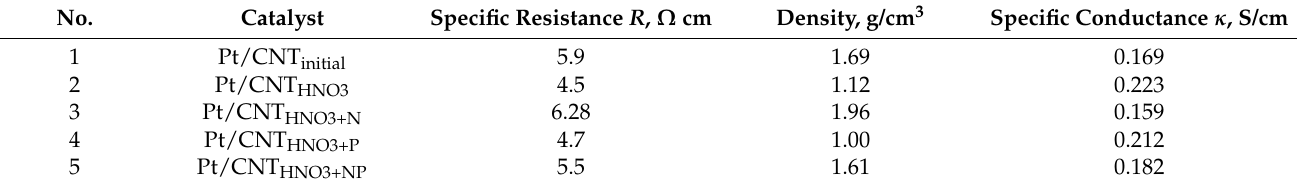
Table 3. Electrical conductivity of monoplatinum catalysts with a sample weight of 0.015